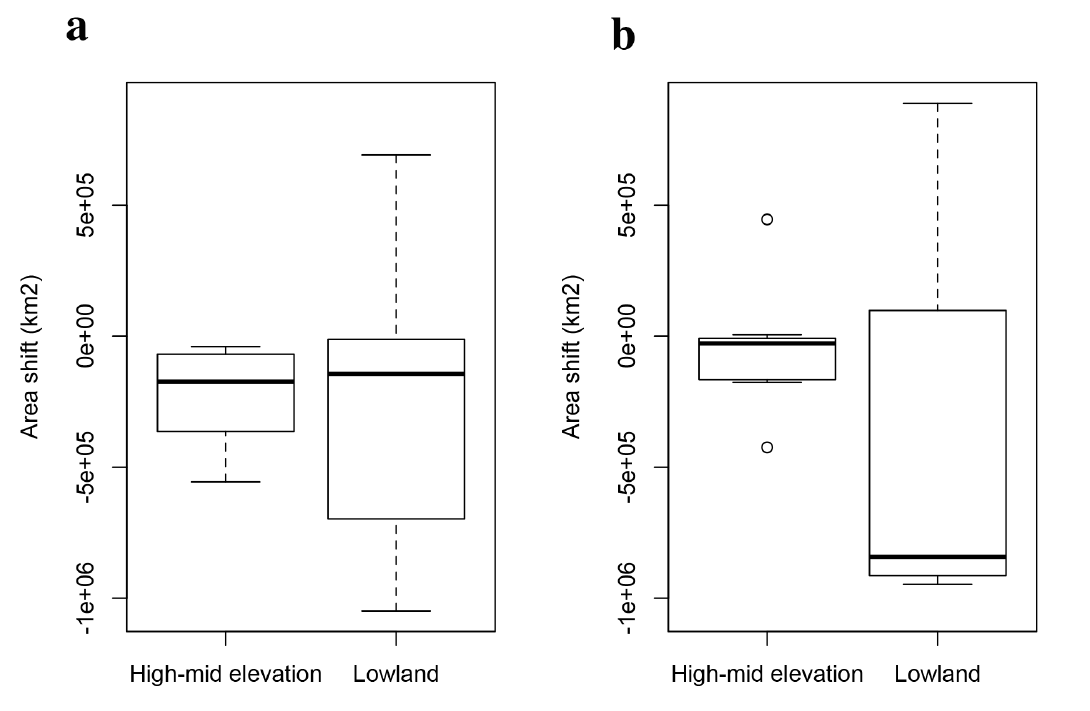
Figure 4. Difference in area obtained from binary predictions of suitable area derived from species distribution models (using a 10 th percentile training presence threshold) for present and two past projections to the last glacial maximum (CCSM and MIROC). a) Difference in area between the present and CCSM projection in square kilometers for montane species (n=7) and lowland species (n=7). b) Difference in area between present and MIROC projection in square kilometers of montane (n=7) and lowland species (n=7). Two-way ANOVA showed an effect of elevational category but no effect of time period or the interaction between elevation and time in predicting changes in area of distribution ( P -value = 5.81 × 10 -6 , 0.367 and 0.671 respectively with F values of 28.196, 1.030 and 0.404, respectively, and 1, 2 and 2 degrees of freedom,